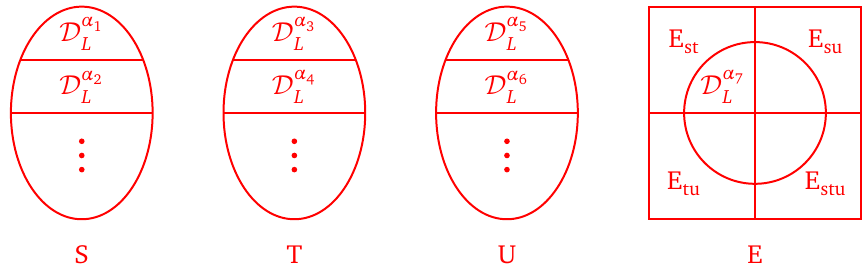
Figure 5.2: The class S, T, U and E are subdivided according causal orderings. For each D α in class E, D α is subdivided according to L L